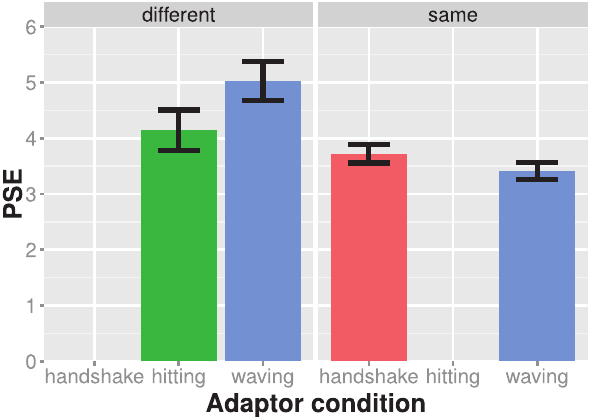
Figure 5. Results of experiment 3. The average PSE is shown for each experiment condition (different panels) and adaptor condition separately. The left panel shows the different emotion condition and the right panel shows the same emotion condition. Larger PSE values indicate that the test stimulus showed more of a waving action. Bars always indicate one standard error of the